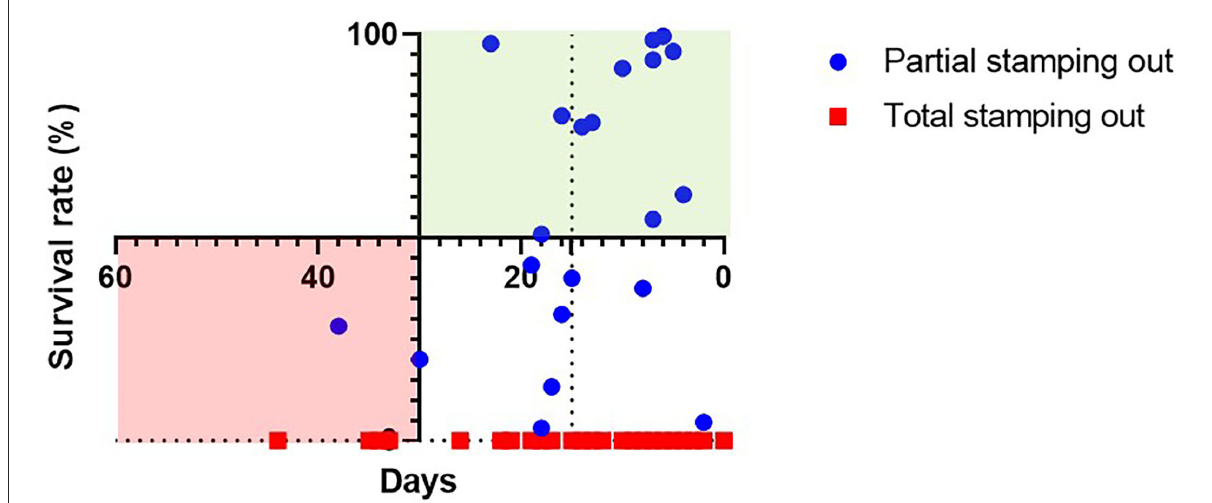
FIGURE4 Modified Cartesian coordinate system on the relation of survival rate (in %) and the length of the disease event (in number of days) on farm. The upper right quadrant (green) standing for optimal, the lower left quadrant (red) for contrasting time efficient and livelihoods protecting